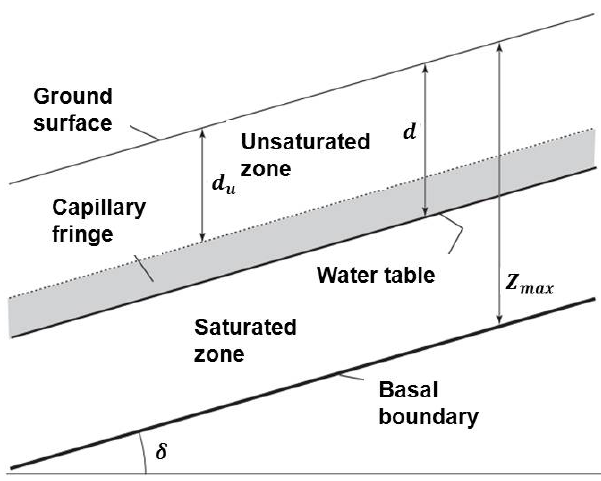
Fig. 5. Conceptual diagram of the TRIGRS model.